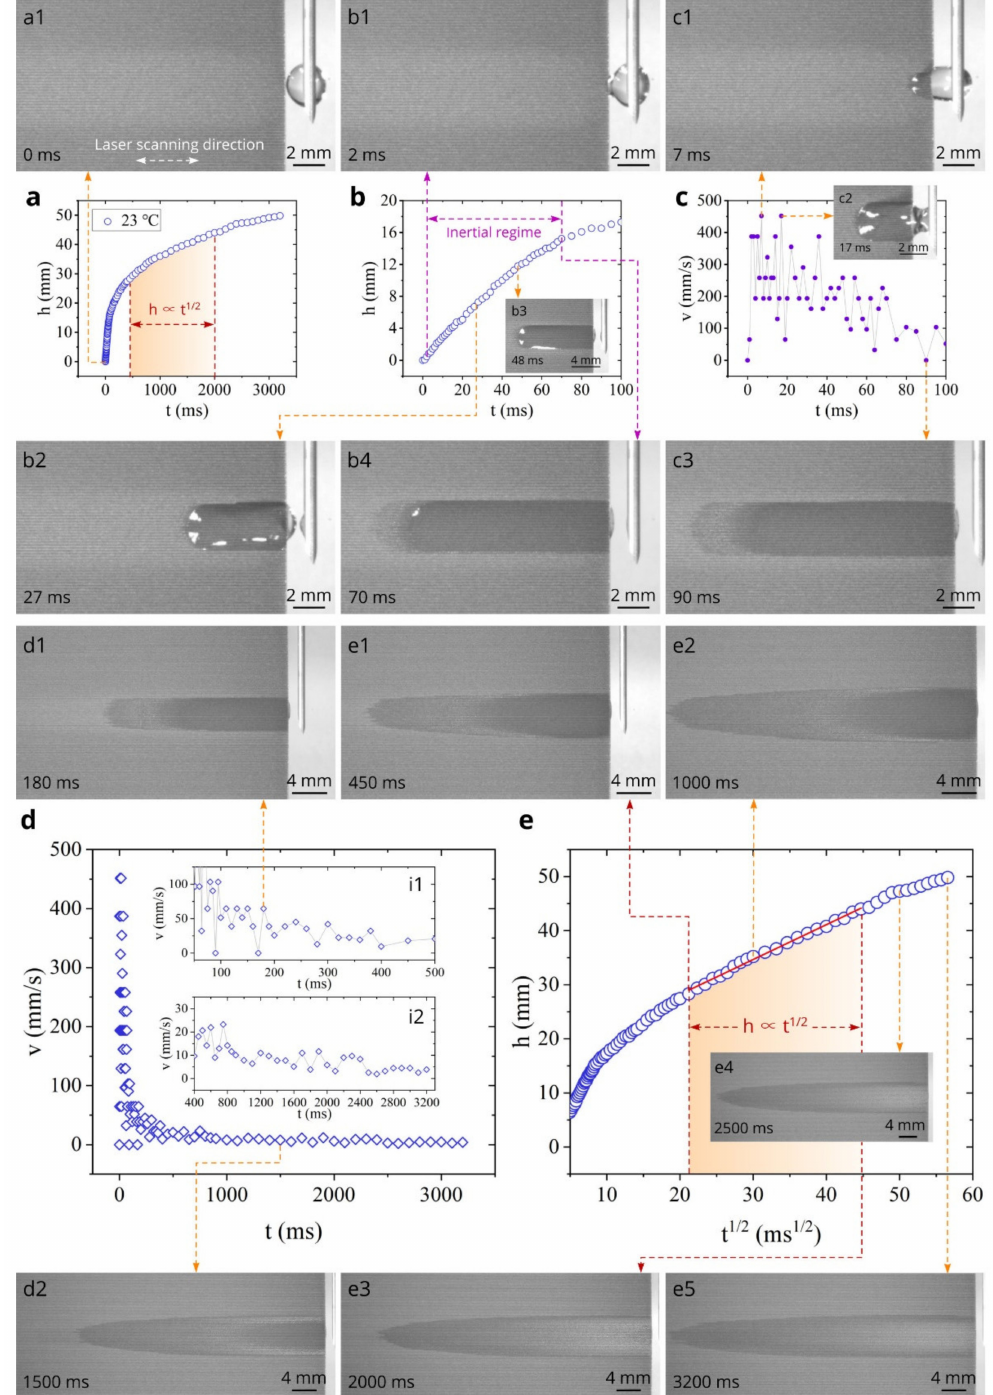
Figure 4. Experimental h ( t ) and v ( t ) plots along with snapshots of water spreading at 23 ◦ C for sample #1. ( a ) Overall plot of the spreading distance as a function of time between 0 and 3200 ms (a1 is a snapshot of the sample surface and water drop at t = 0). ( b ) Detailed plot of the spreading distance as a function of time between 0 and 100 ms (b1–b4 are snapshots of water spreading associated with h ( t ) dependence). ( c ) Plot of the velocity as a function of time between 0 and 100 ms (c1–c3 are snapshots of water spreading associated with v ( t ) dependence). ( d ) Overall plot of the velocity as a function of time between 0 and 3200 ms (d1, d2 are snapshots of water spreading associated with v ( t ) dependence. The insets i1 and i2 show detailed v ( t ) dependencies in the time domains of 100–500 and 400–3200 ms, respectively). ( e ) Plot of the spreading distance as a function of t 1/2 (e1–e5 are snapshots of water spreading associated with Washburn’s regime). (Note: Bleaching of surface in the middle of the sample seen in Snapshots of both this and Figures 5 and 6 is discussed in paper